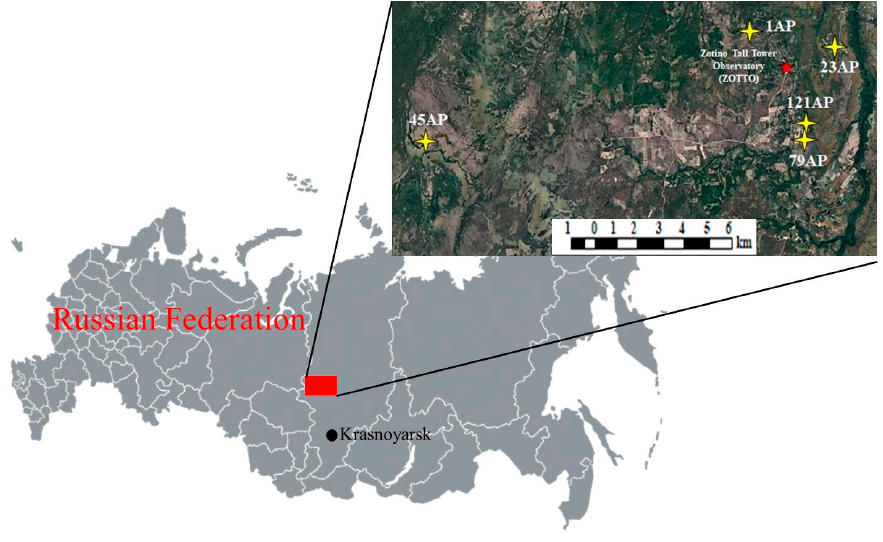
Figure 1. Location of study sites (the scheme is based on http://www.glovis.usgs.gov, accessed on 30 December 2022).